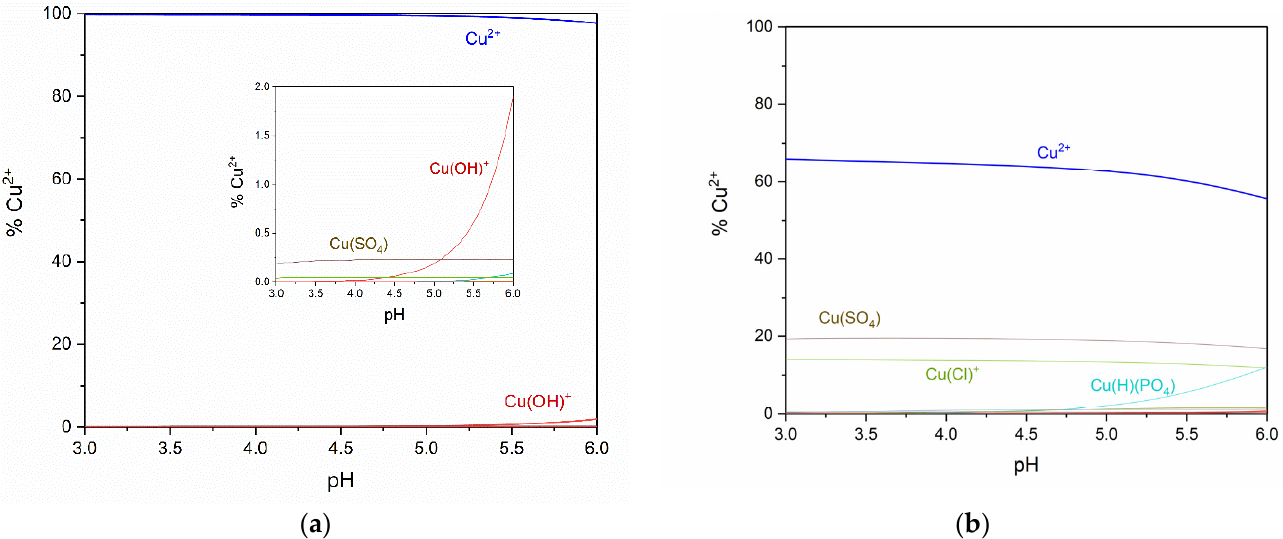
Figure 5. Species of Cu(II) occurring in the soluble fraction of the atmospheric deposition sample D1-1, as a function of pH: ( a ) sample D1-1 (the inset graph shows the species distribution with an enlarged scale); ( b ) sample D1-1, with concentration increased by a factor 10 3 .